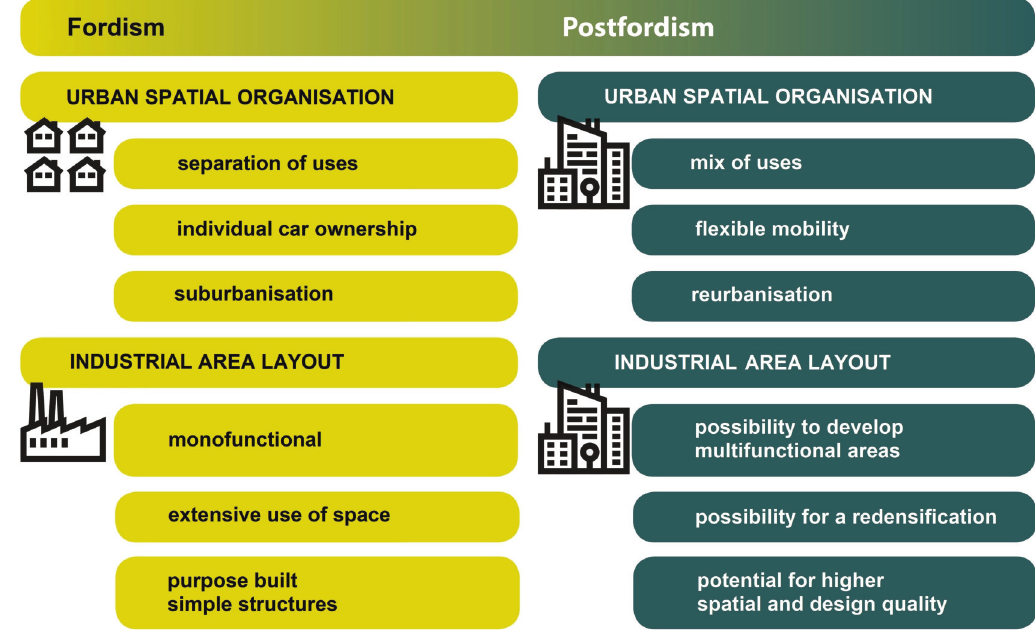
Figure 2. Comparison of the urban spatial organisation and industrial area layout in Fordism and